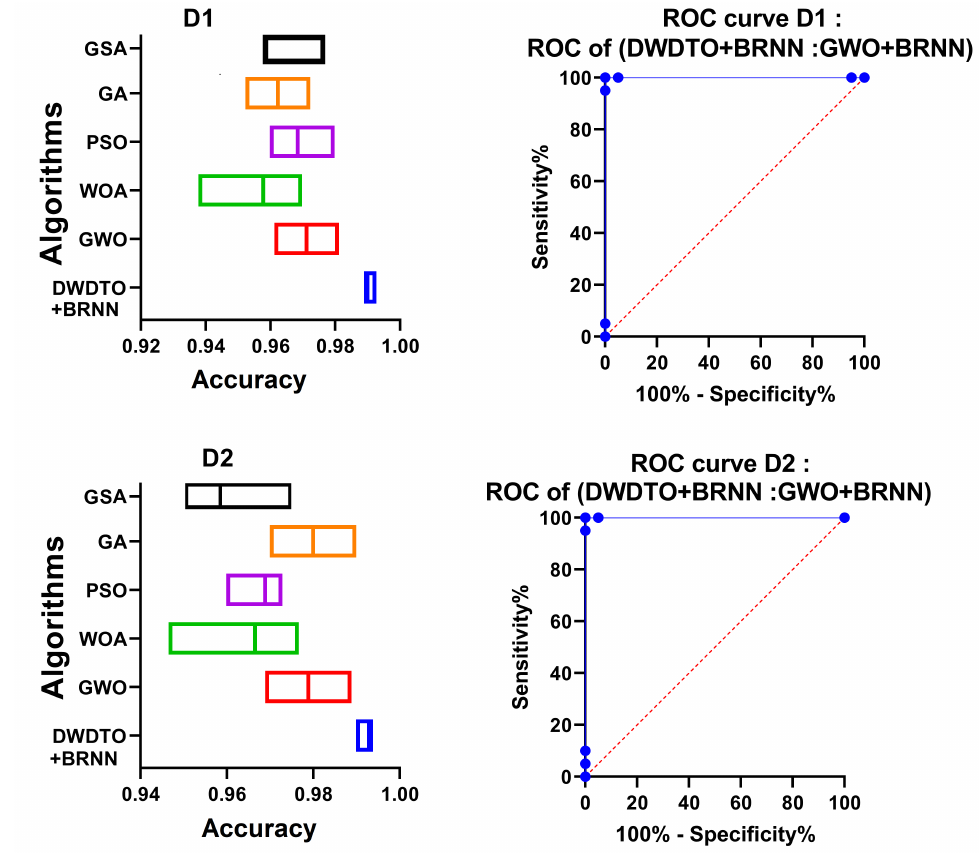
Figure 13. Comparison between the performance of the proposed optimization algorithm and the other competing algorithms applied to the two datasets, D1 and